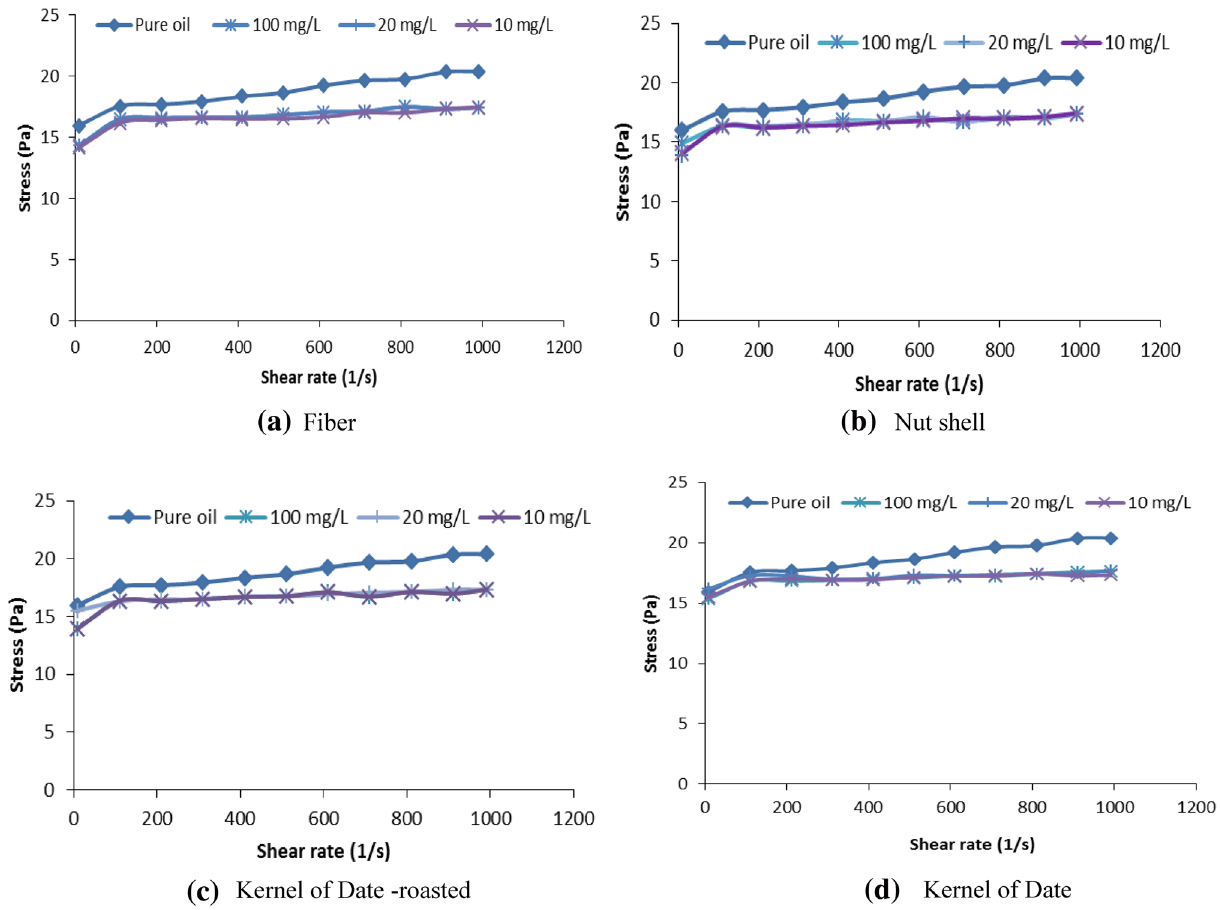
Fig. 13 Shear rate of heavy crude oil using bio materials (150 µm)